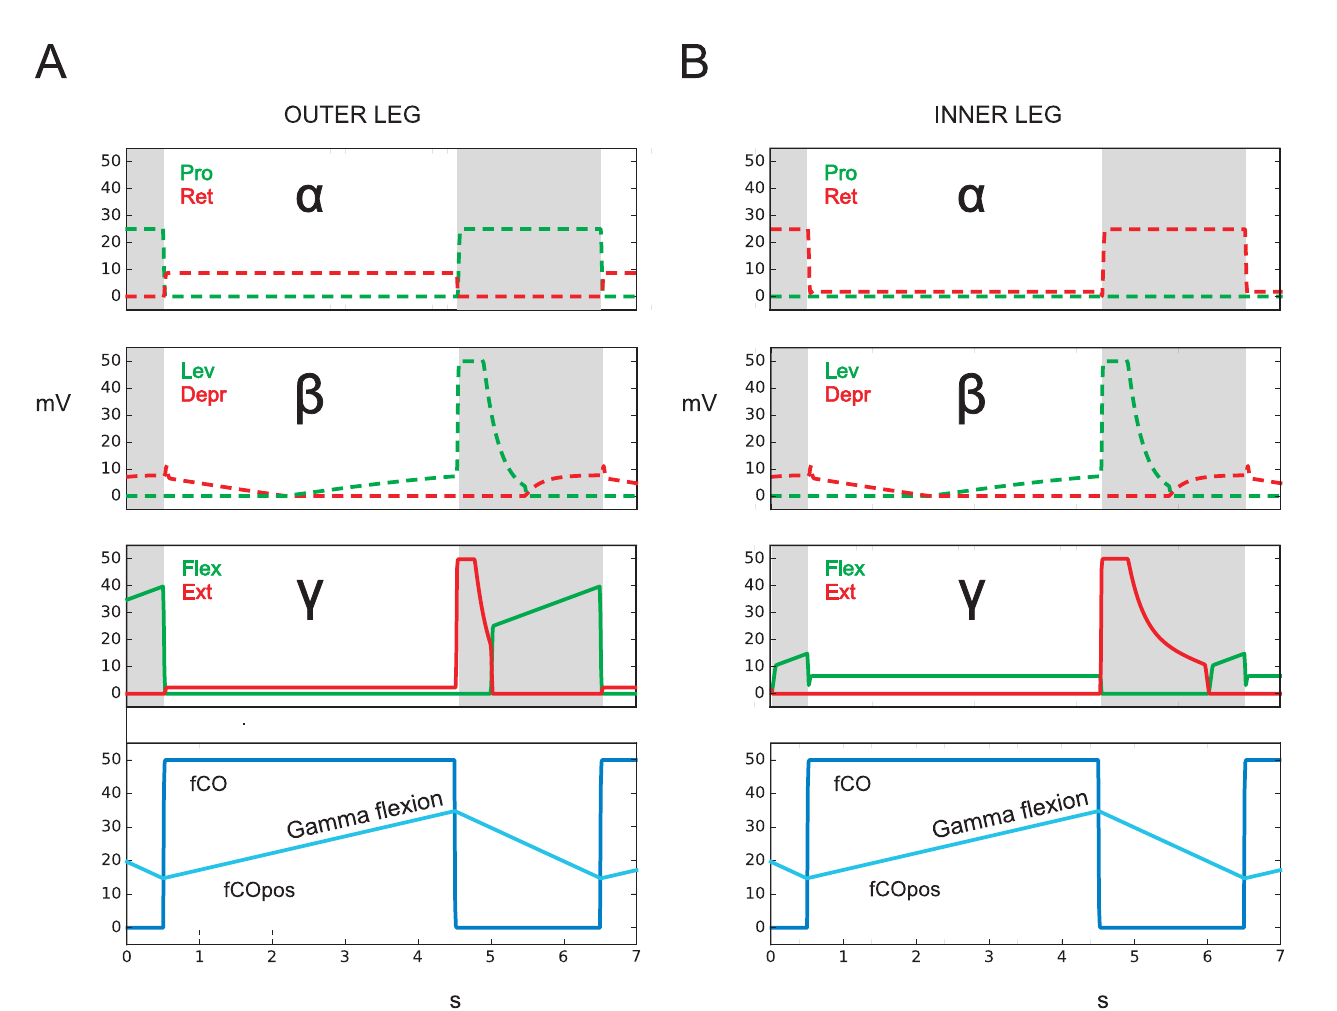
Fig 4. Negotiation of curves (turn to the right). fCO stimulus (elongation) drives flexor or extensor as observed in [26], but here front legs are shown. Activation of fCO stimulus (bottom row: blue). A) outer (left) front leg, B) inner (right) front leg. Abscissa: time (s), ordinate (mV). Dashed lines: simulation data for which no biological results are given. fCOpos (light blue line) indicates fCO apodeme position. fCO: input to unit swing or unit stance.